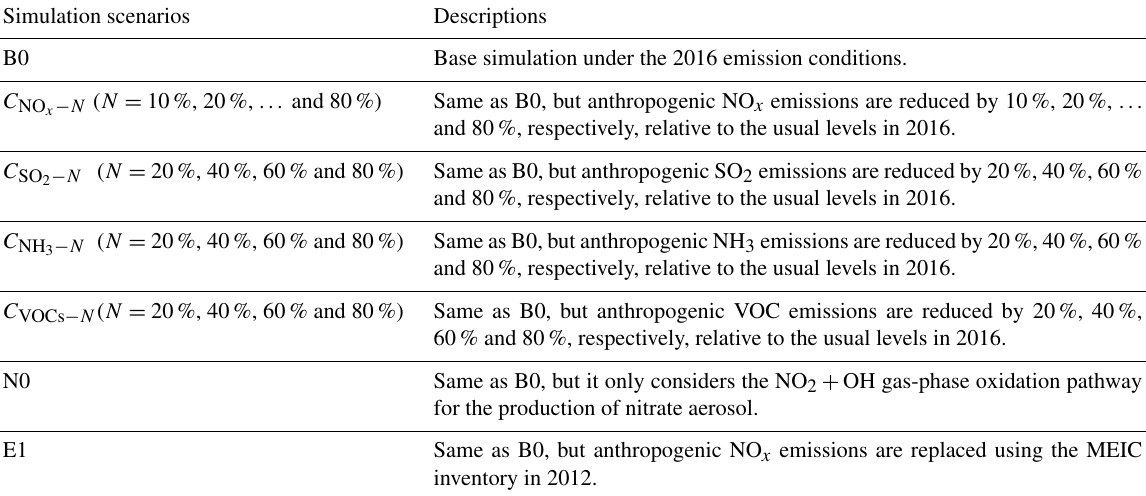
Table 1. The emission scenarios in WRF-Chem numerical experiments. Simulation